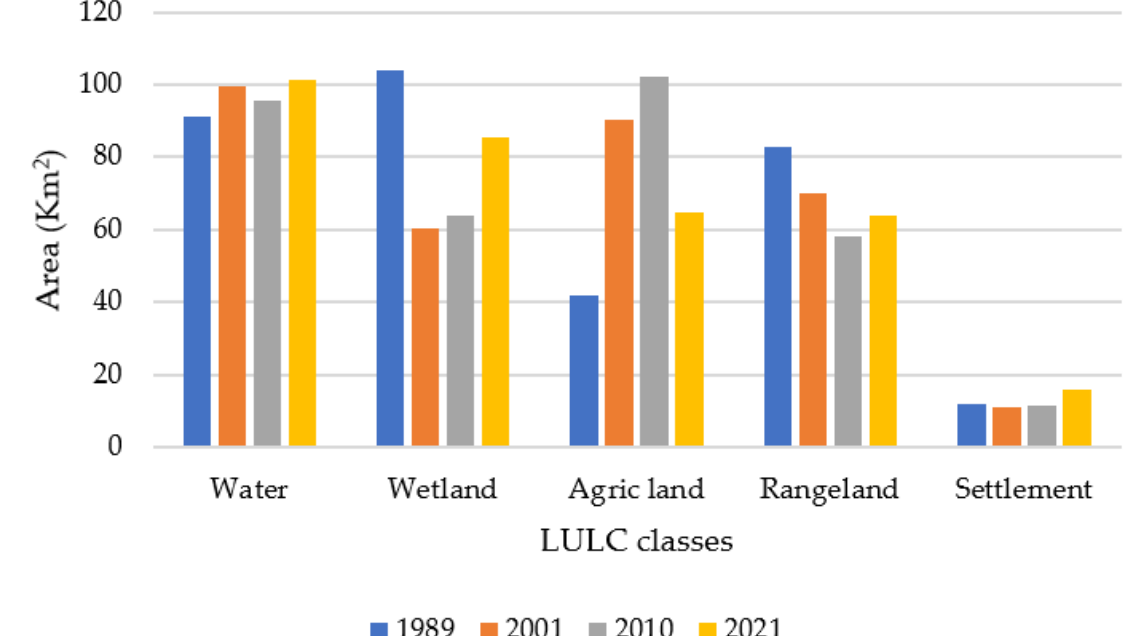
Figure 5. Land use land cover changes in the immediate catchment of Lake Kyoga from 1989 to 2021.